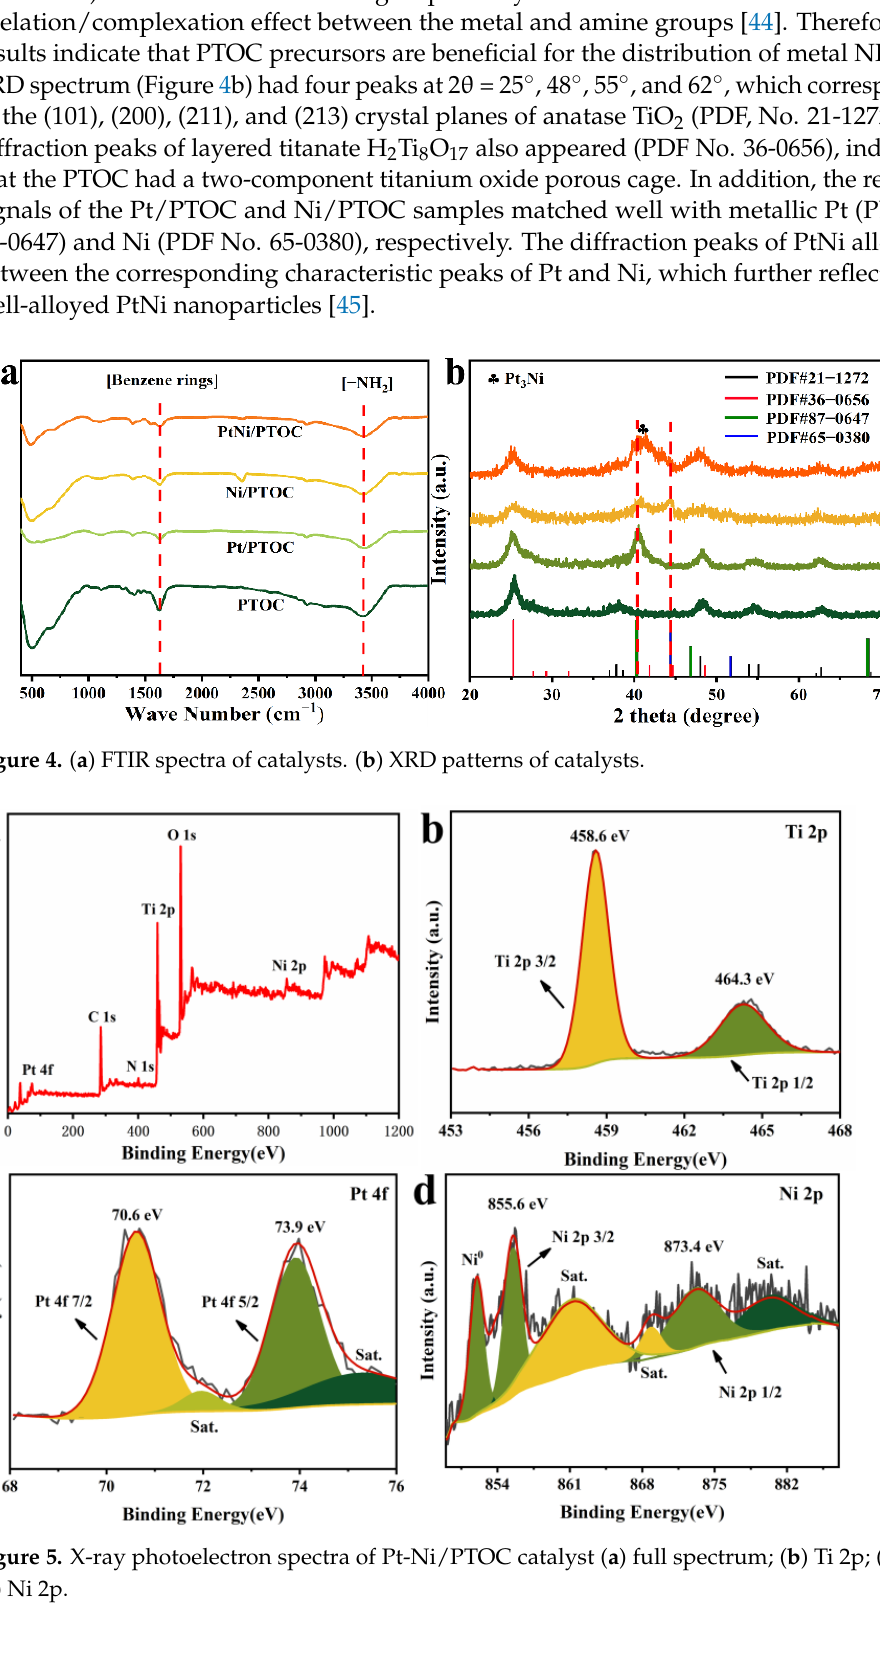
Figure 3. TEM images of ( a , b ) PtNi/PTOC catalyst; ( c ) HRTEM; ( d ) HADDF-STEM ( e – h ); EDX im- ages of PtNi/PTOC.